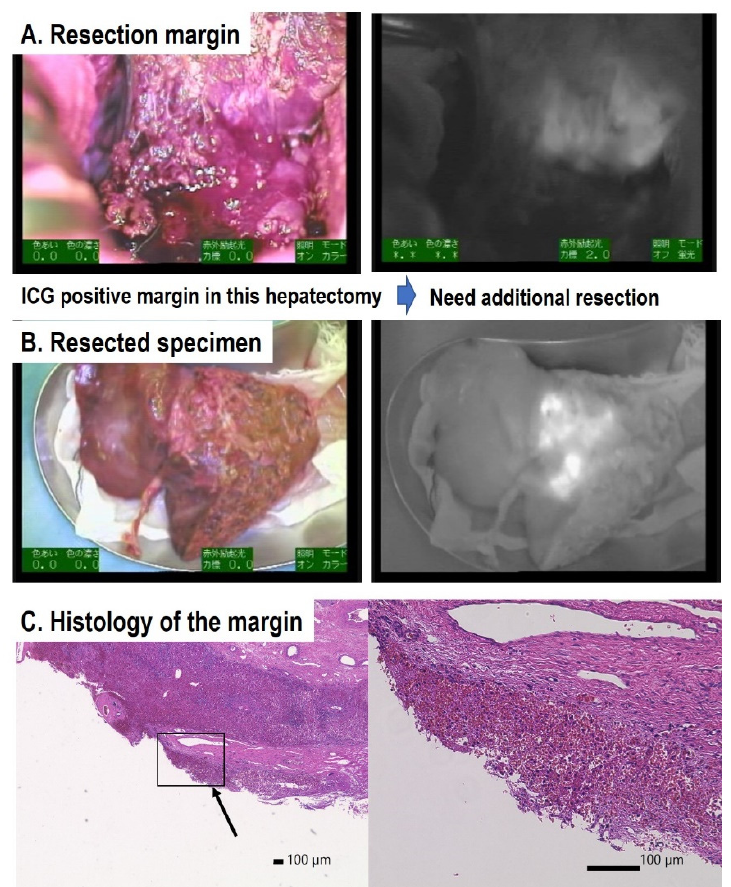
Figure 3. Detection of marginal residual tumor cells by ICG fluorescence. ( A ) Resected margin: ICG was positive. ( B ) Resected specimen: resected margin was also ICG positive. ( C ) Microscopic examination of the margin. Histological examination suggests that the margin of the resected speci- men might be positive (arrow). The higher-magnification field revealed the existence of malignant tumor